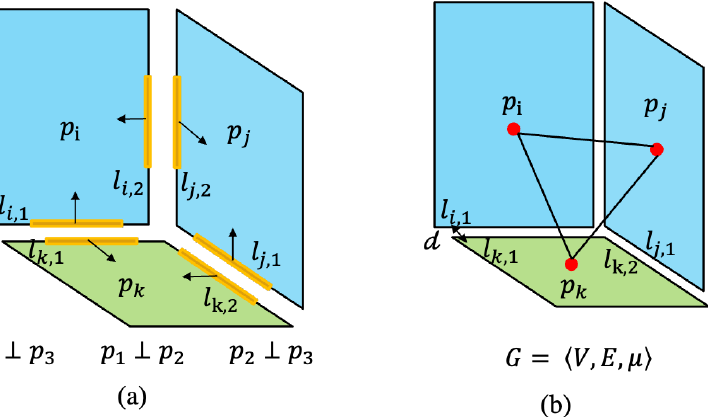
Figure 3. Two topologic relations in an indoor structure: ( a ) structural relations determined with the boundary lines and mathematical primitives and ( b ) geometric relations between estimated